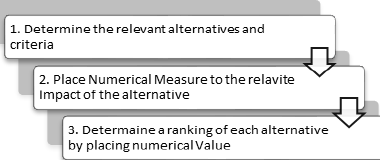
Figure 3: Decision Making Process